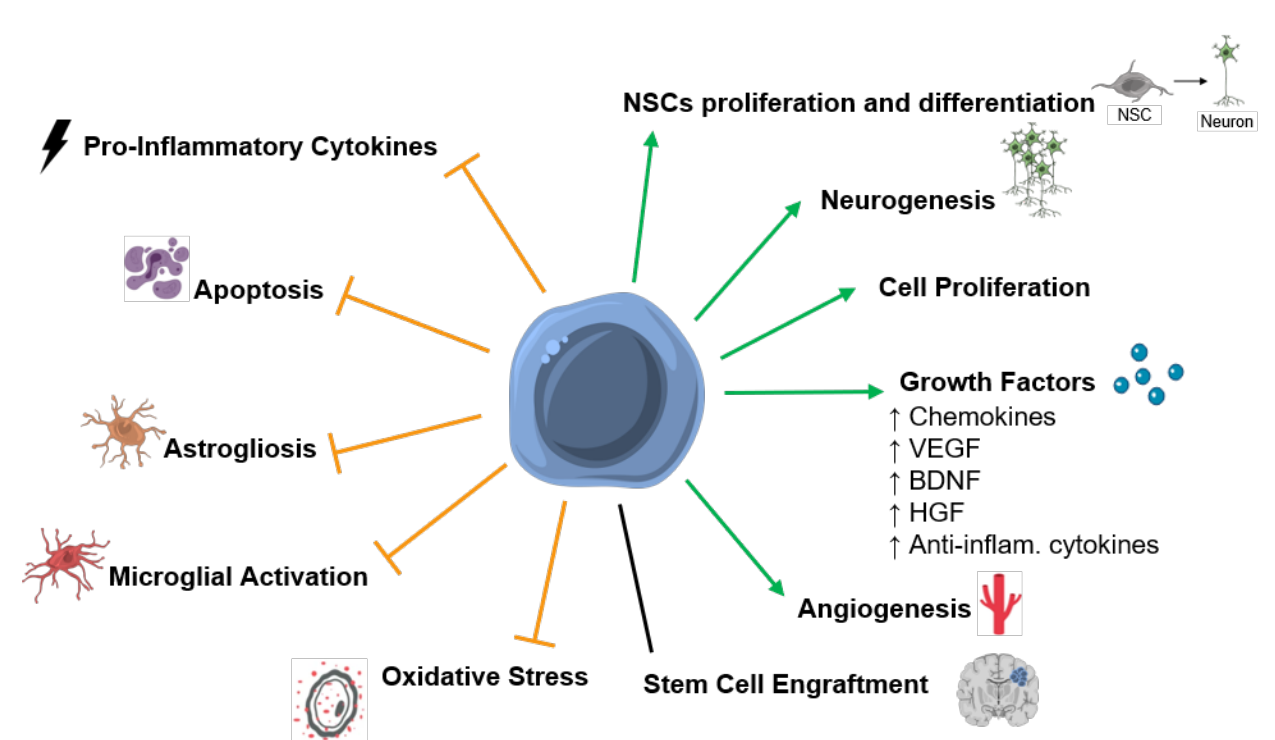
Figure 1. Mechanisms of action of stem cells identified by the preclinical studies included in this systematic review. Several mechanisms of action that might be mediating the positive functional outcomes observed after SCT in preclinical models of neonatal hypoxic-ischemic encephalopathy (HIE). Stem cell therapy (SCT) was associated with the promotion or upregulation (green arrows) of neuronal stem cells (NSCs) proliferation and differentiation, neurogenesis, cell proliferation, growth factors levels/secretion, angiogenesis, and inhibition or downregulation (orange truncated arrows) of pro-inflammatory cytokines, apoptosis, astrogliosis, microglial activation, and oxidative stress. Also, some studies report stem cell engrafment after SCT, while other report low or no engrafment. Abbreviations: Anti-inflam—anti-inflammatory; BDNF—brain-derived neurotrophic factor; HGF—hepatocyte growth factor; VEGF—vascular endothelial growth factor.